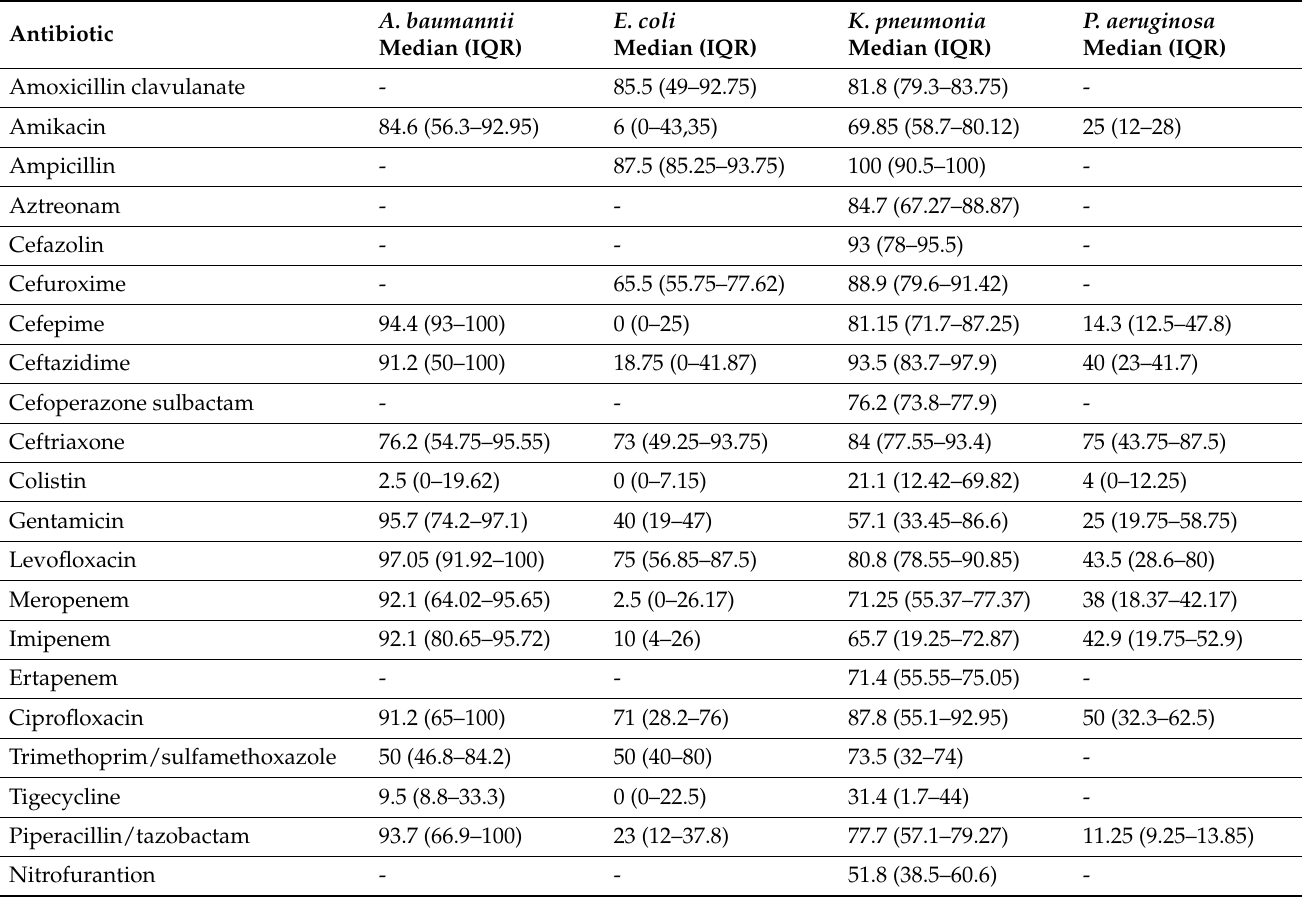
Table 2. Gram-negative bacteria resistant to tested antibiotics during